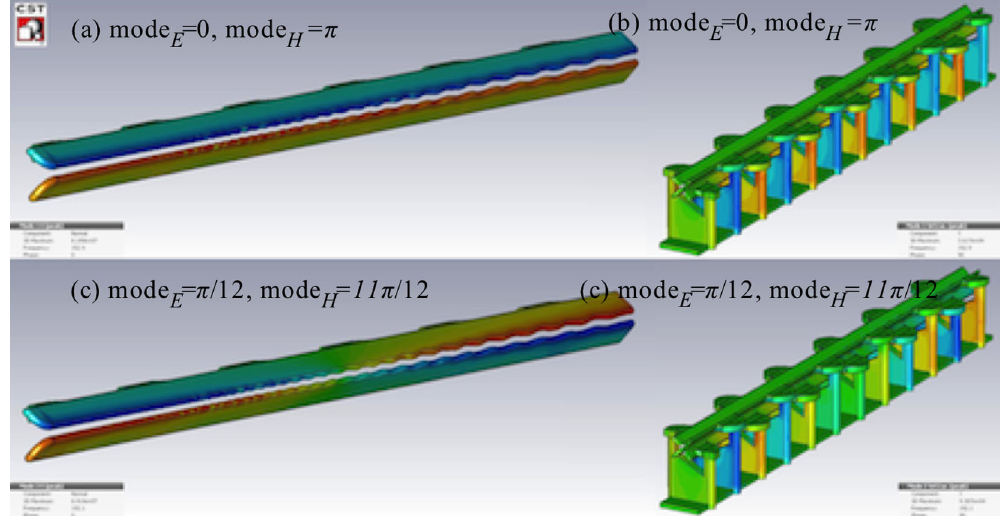
FIG. 16 (color online). The FNAL RFQ normal E-field component on the electrodes of the first two modes are shown in (a) and (c) and their corresponding currents on the stems are shown in (b) and (d). Both modes are quadrupole modes. The first mode has a constant E-field ( q ¼ 0 ) while the second mode shows one change in the field polarity ( q ¼ 1 ) along the structure. The quadrupole mode of the E-field is mode E ¼ 0 in the fundamental state with the corresponding H-field having mode H ¼ π . The highest quadrupole mode for the four-rod RFQ is mode E ¼ π with mode H ¼ 0 combination.